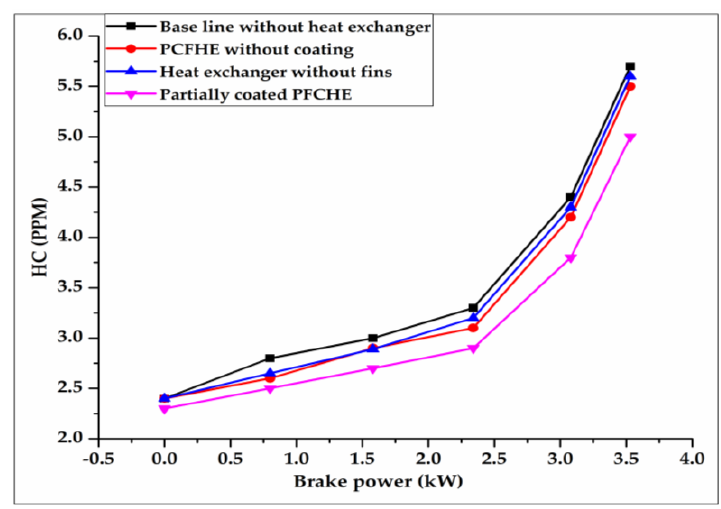
Figure 9. Effect of heat exchanger on HC emission.